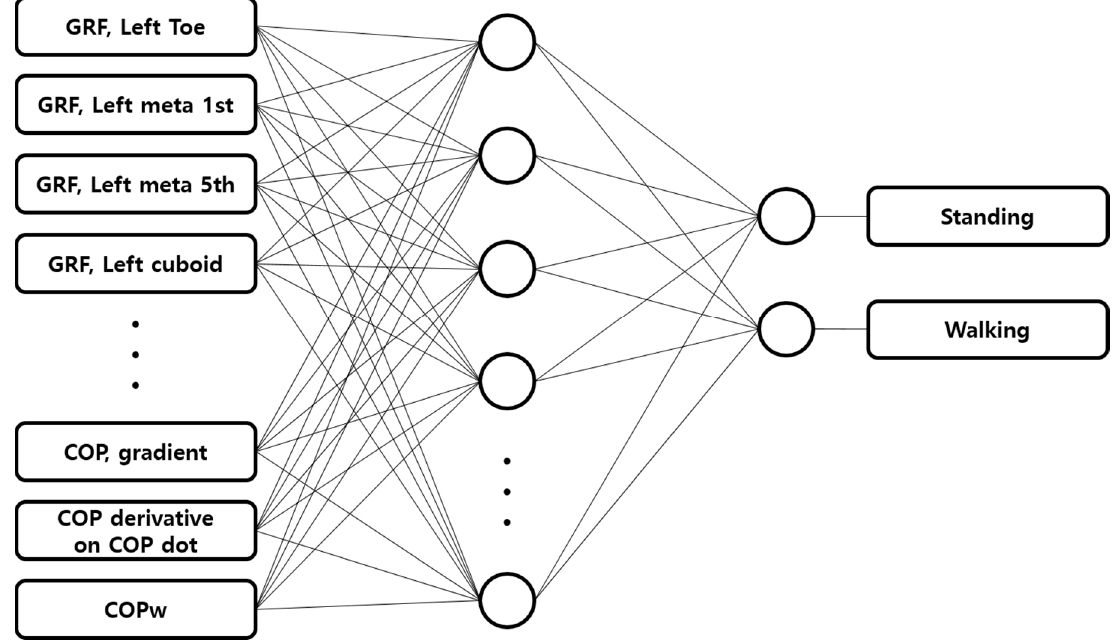
Figure 5. Diagram of the developed artificial neural network (ANN) model.